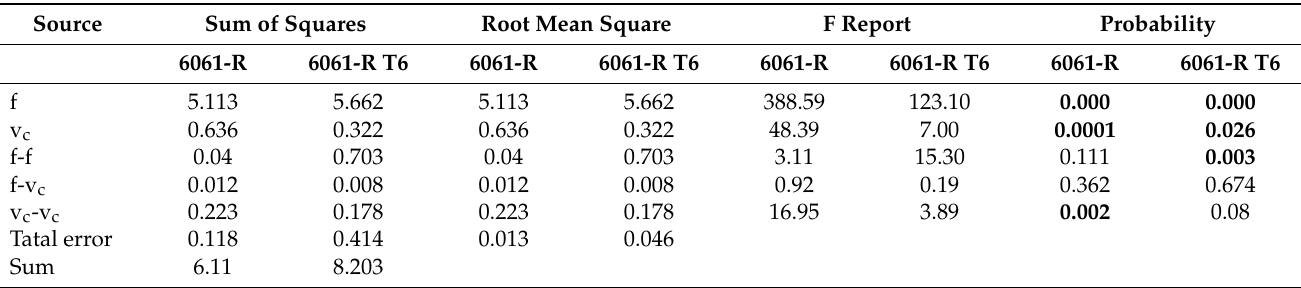
Table 5. Analysis of variance on surface roughness for 6061 R alloy and 6061 R-T6 alloy dry machined. Source Sum of Squares Root Mean